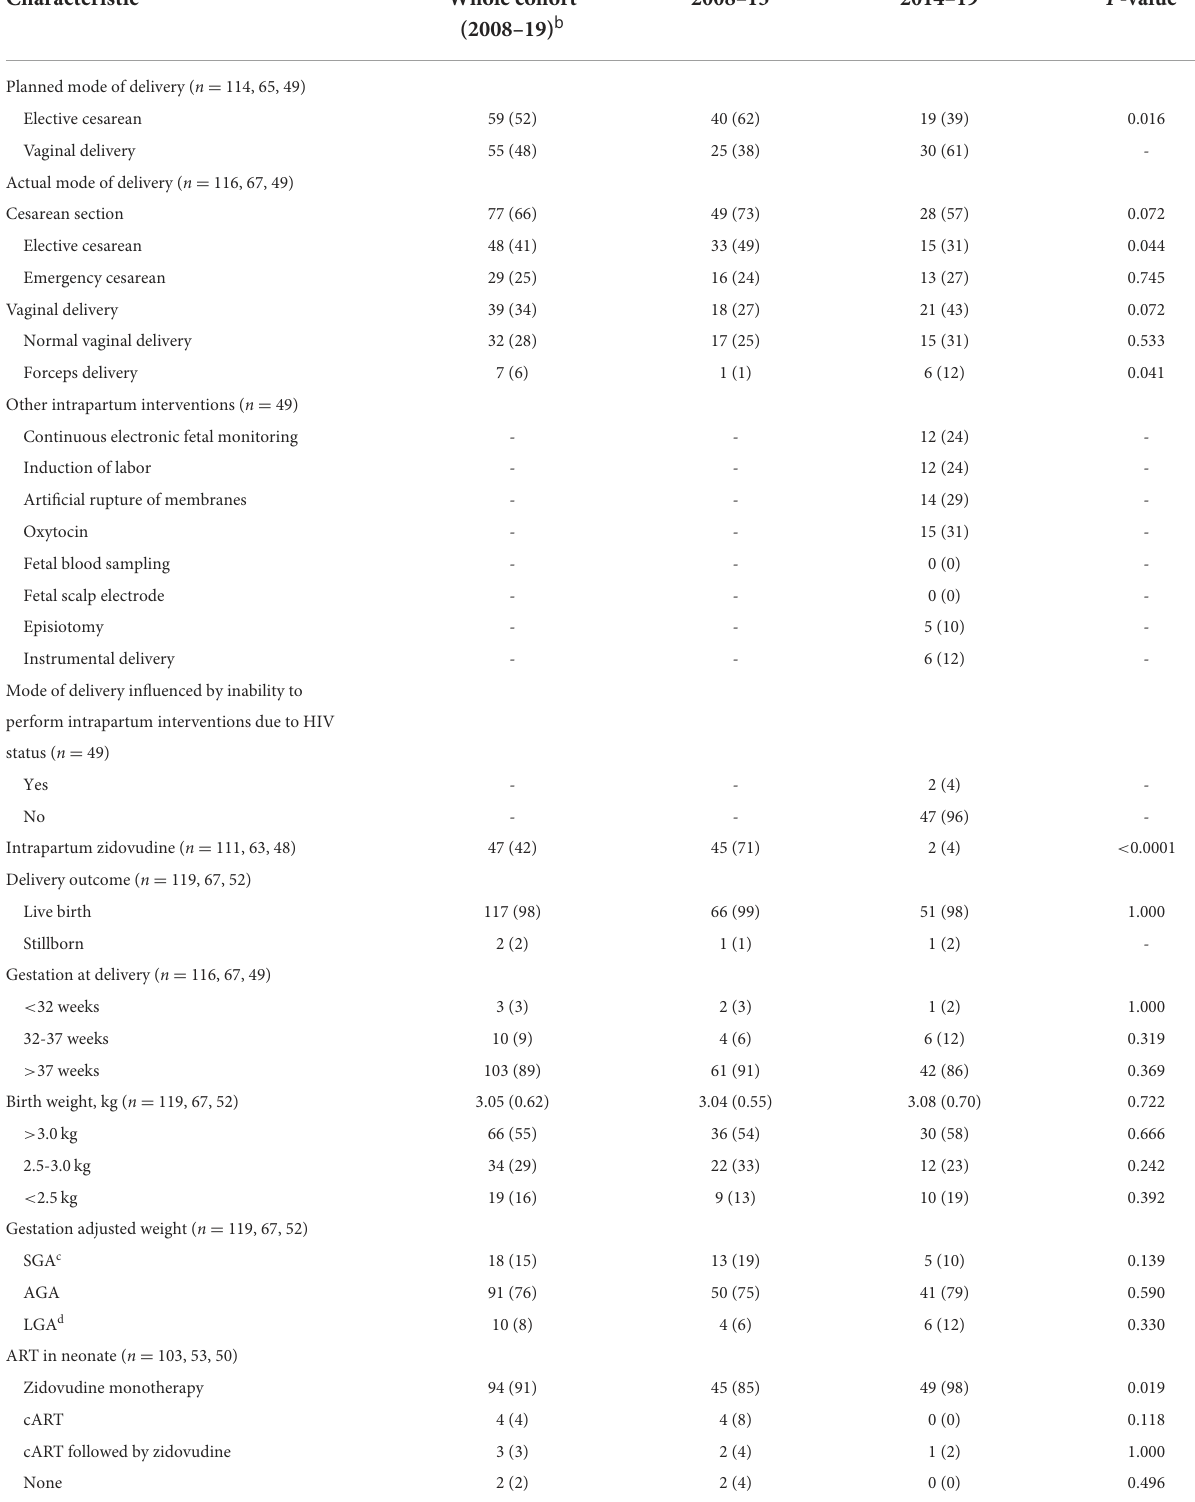
TABLE 4 Delivery and neonatal